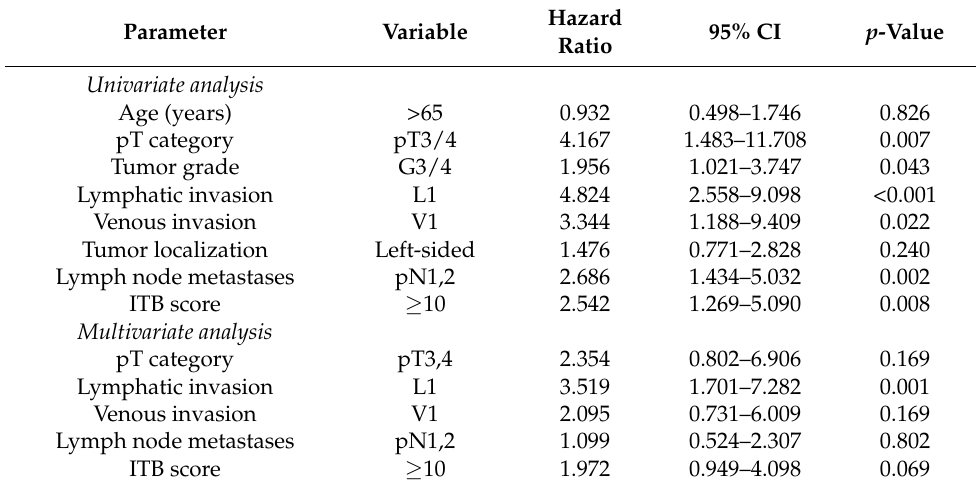
Figure 5. ITB score and clinicopathological parameters. Difference between the groups is shown, depending on the ITB score and ( A ) T category (T stage/UICC), ( B ) lymph node invasion/positive lymph nodes, ( C ) perineural invasion (not defined in 7 cases), and ( D ) tumor grading. The number of cases is shown in brackets. ( A – C ) Mann–Whitney U test; ( D ) Kruskal–Wallis test. Table 2. Univariate and multivariate Cox regression analyses for risk of metastasis ( n = 245).